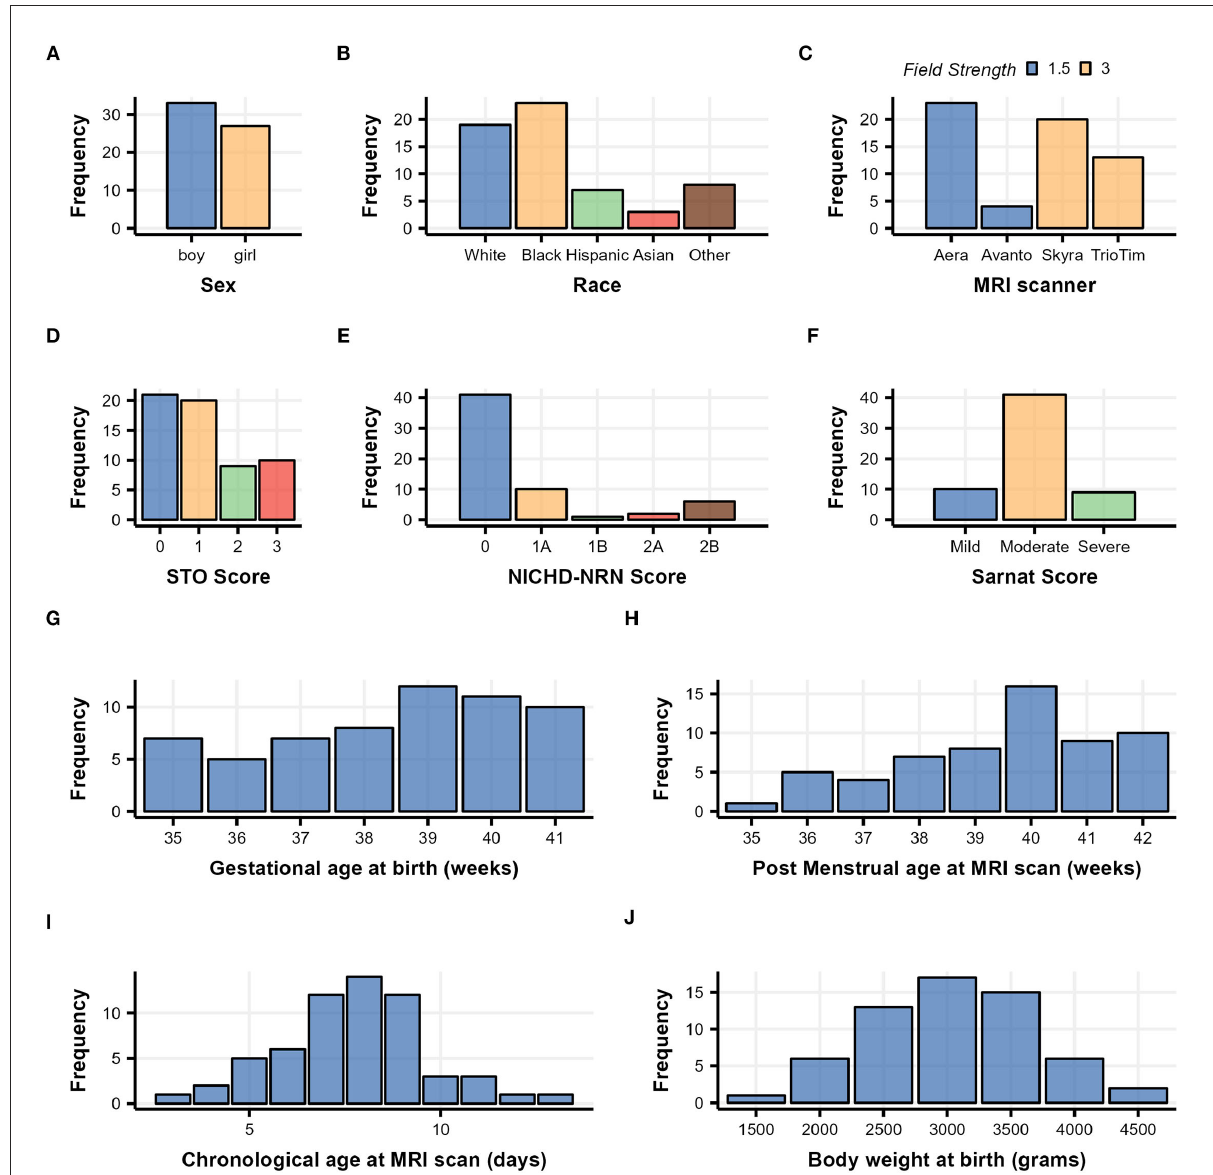
FIGURE1 Demographic histograms of 60 subjects with neonatal HIE who underwent therapeutic hypothermia treatment. Categorical clinical variables are summarized in (A–F) with color scaled by variables, and continuous clinical variables are summarized in (G–J)